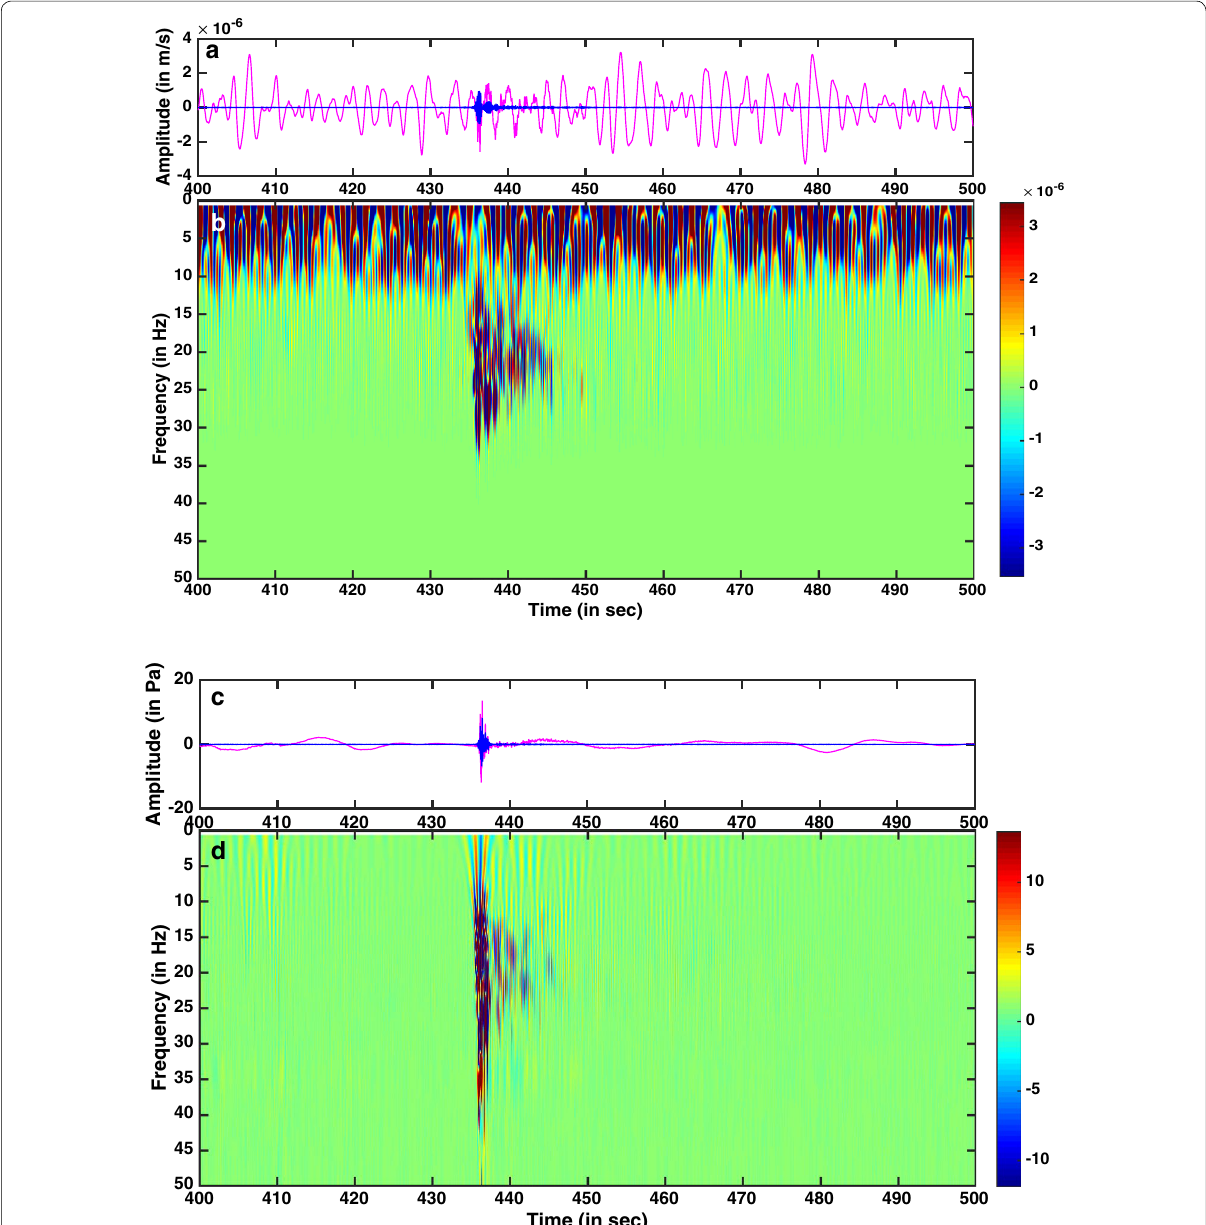
Fig. 2 Unfiltered and filtered time series for seismic and infrasound records and their corresponding wavelet spectrograms. a Broadband seismo- gram of station SXI1: magenta and blue curves are the unfiltered and filtered time series, respectively. b Wavelet spectrogram for the seismogram ( a ). c , d Same as ( a , b ) but for the infrasound record (Station SXI1). Here the time axis is referenced to 2013.12.05 10:10:00 UTC (arbitrarily